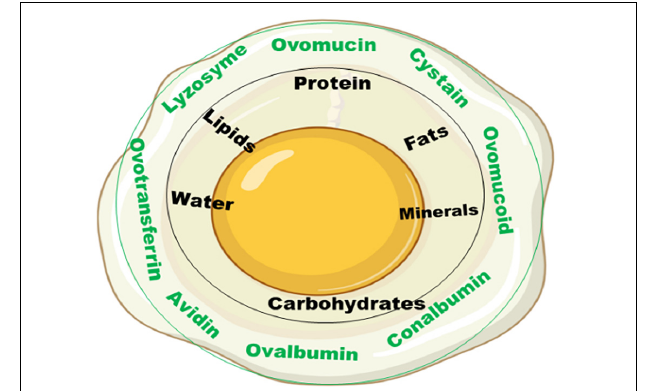
FIGURE 1 | Albumen structure and its